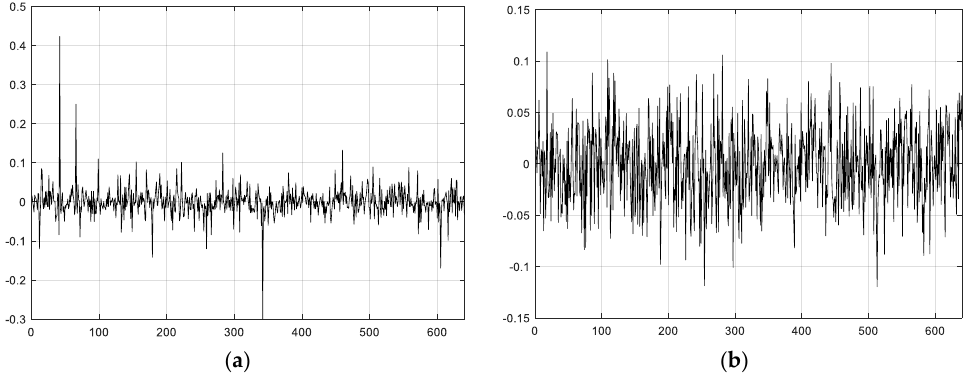
Figure 5. Wavelet functions of the first scheme: ( a ) 2nd-level wavelet function; ( b ) 10th-level wavelet function. Sensors 2018 , 18 , x